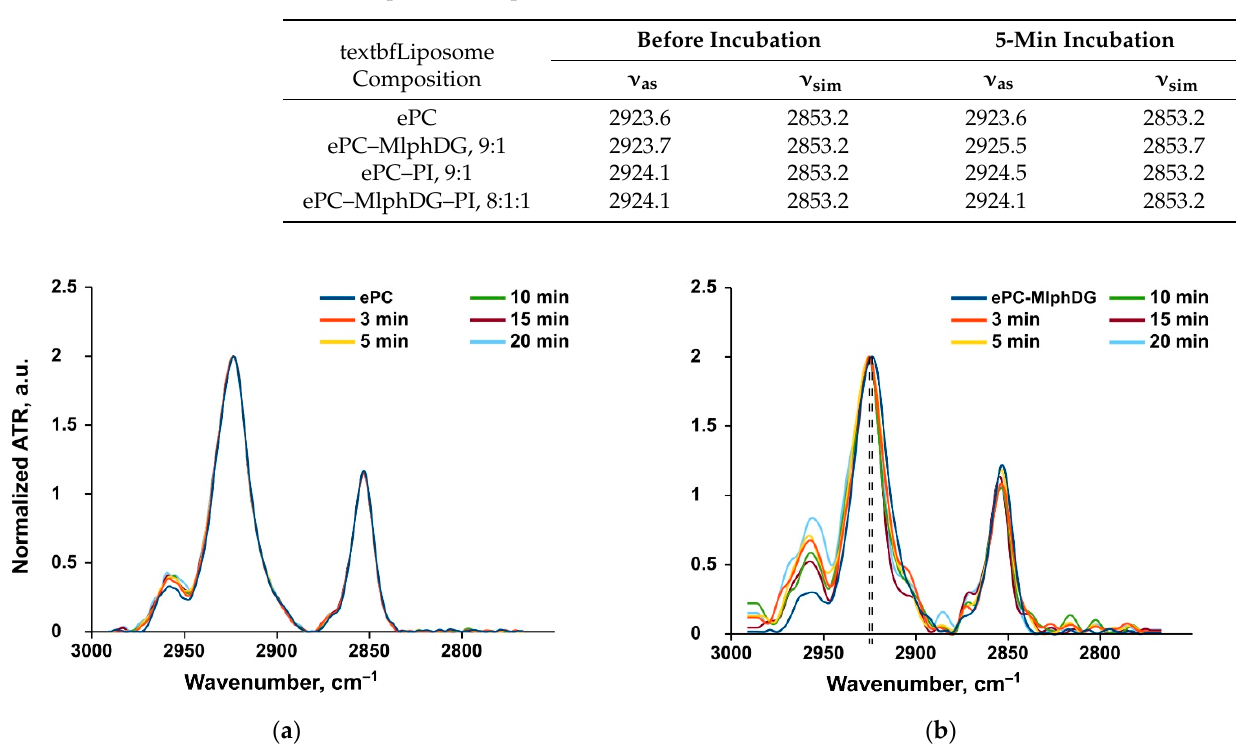
Table 4. Stretching vibration frequencies (cm − 1 ) of lipid methylene groups upon incubation of different liposome samples with serum albumin.